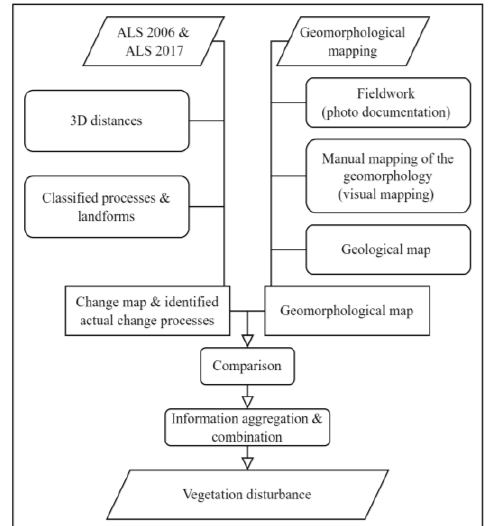
Figure 2 . Overall workflow and combination of the main sources of information.